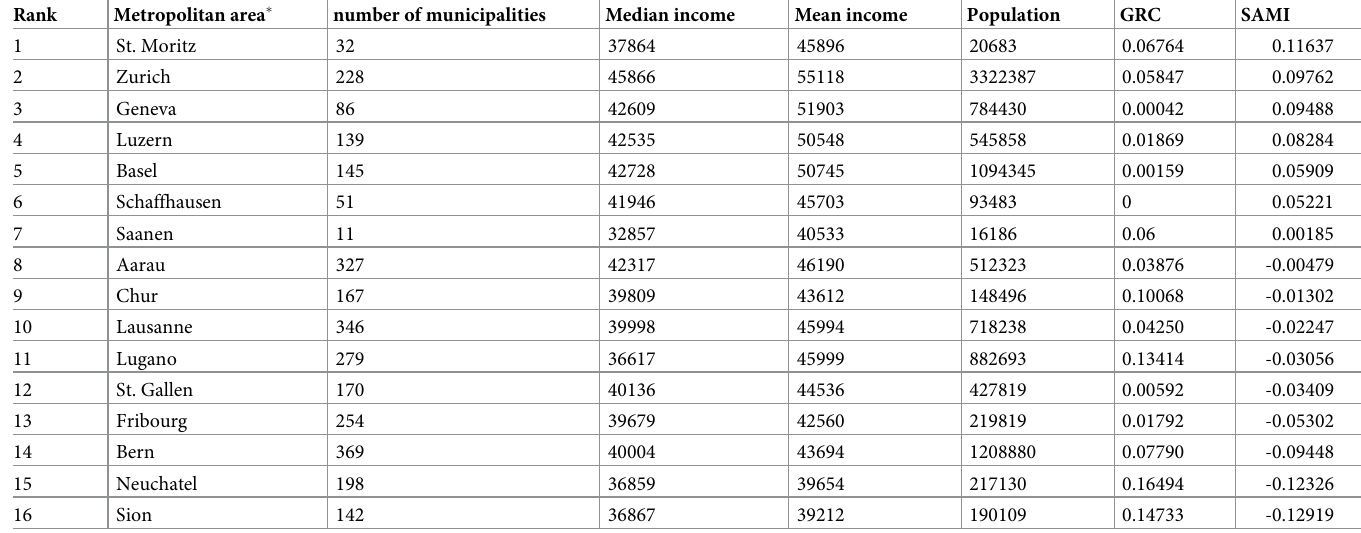
Table 1. Ranked Swiss metropolitan areas based on SAMI and related statistics (GRC hierarchy, Population size, Median and Mean income